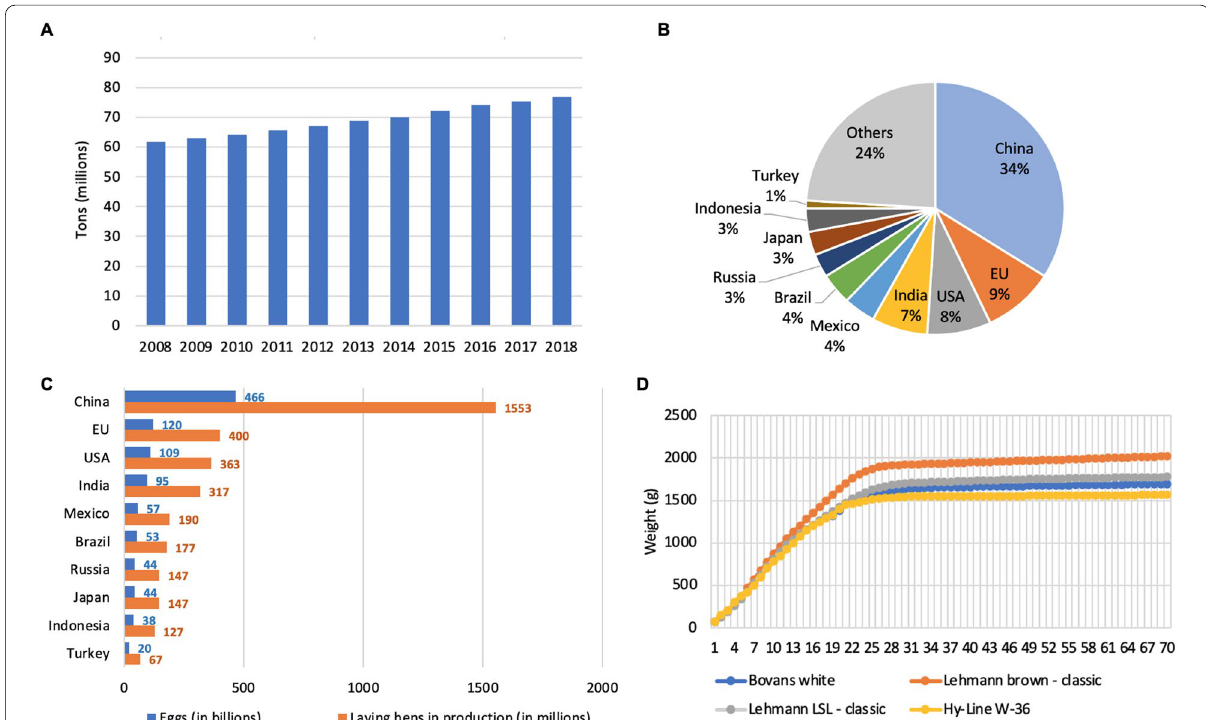
Fig. 1 Profiles of egg and laying hen production. A Global egg production of 2008–2018. B Share of world market in egg production of global major producers in 2018. C Production of eggs (billions) and egg-laying hens (millions) of global major producers in 2018. Egg production was obtained from International Egg Commission; the number of spent hens were calculated based on the egg-laying capacity of 300 eggs/hen per year (Alders et al. 2018). D Body weight performance of several layer species. Body weight reference data of Bovans white, Lehmann brown, Lohmann Selected Leghorn (LSL), and Hy-Line W-36 referred to the management guide of New-Life Mills, Lohmann Breeders, and Ly-Line, respectively